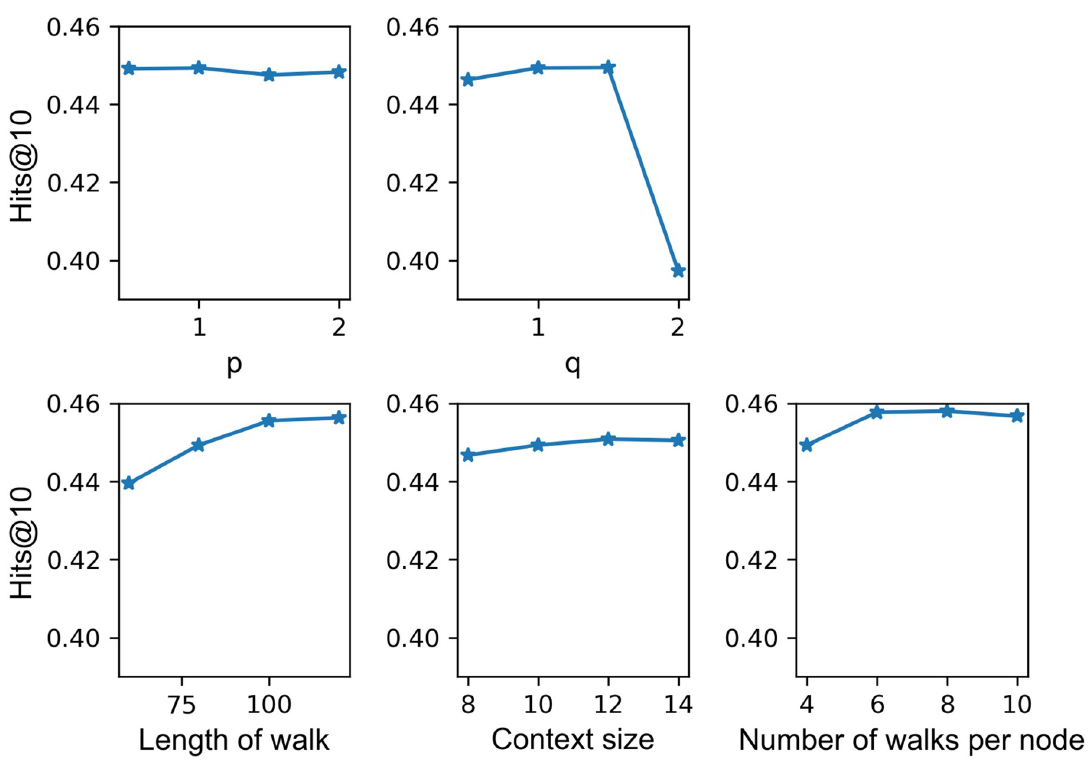
Fig 7. Sensitivity of proposed cascade model to parameters of Node2vec.